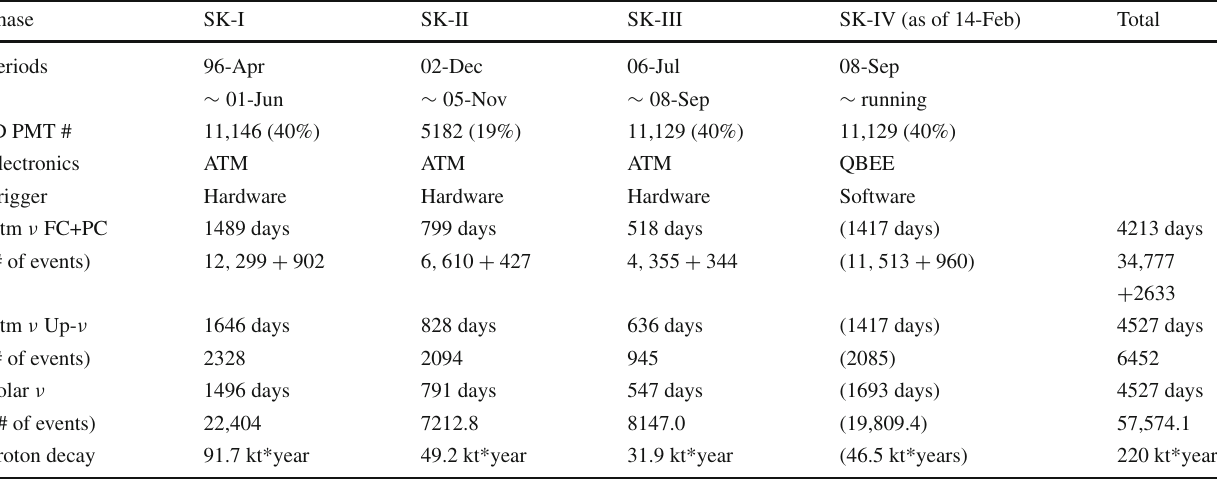
Table 1 Running phases of Super-Kamiokande and total number of data accumulated